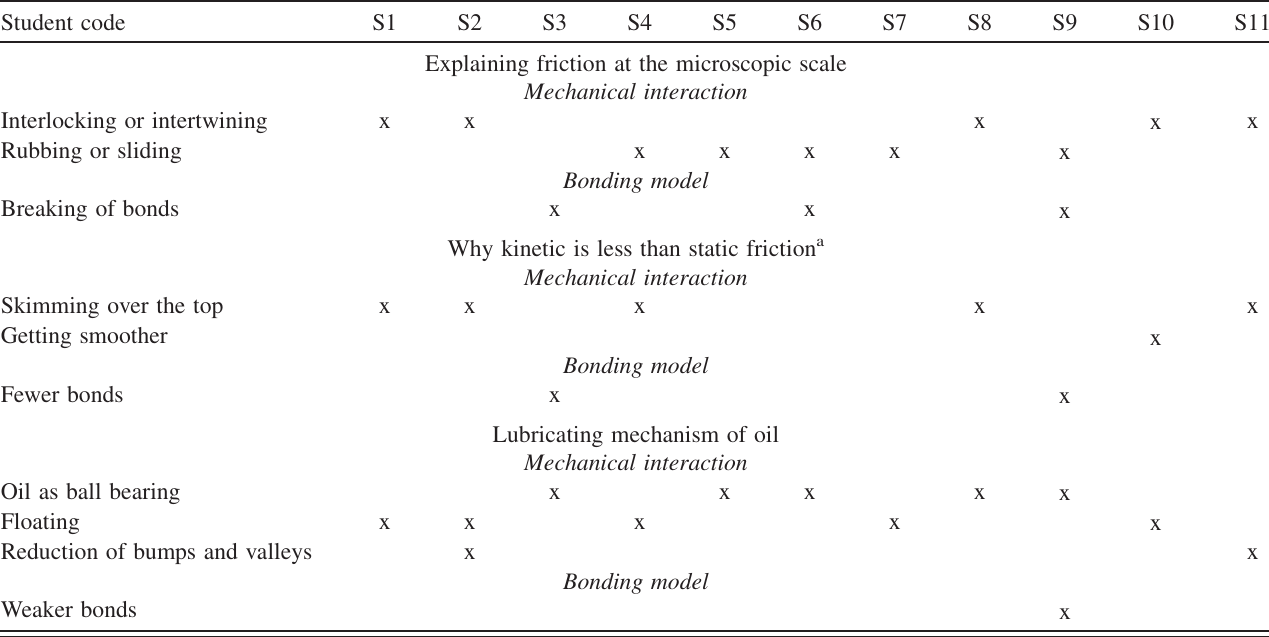
TABLE III. Variations of student models in the different contexts in the